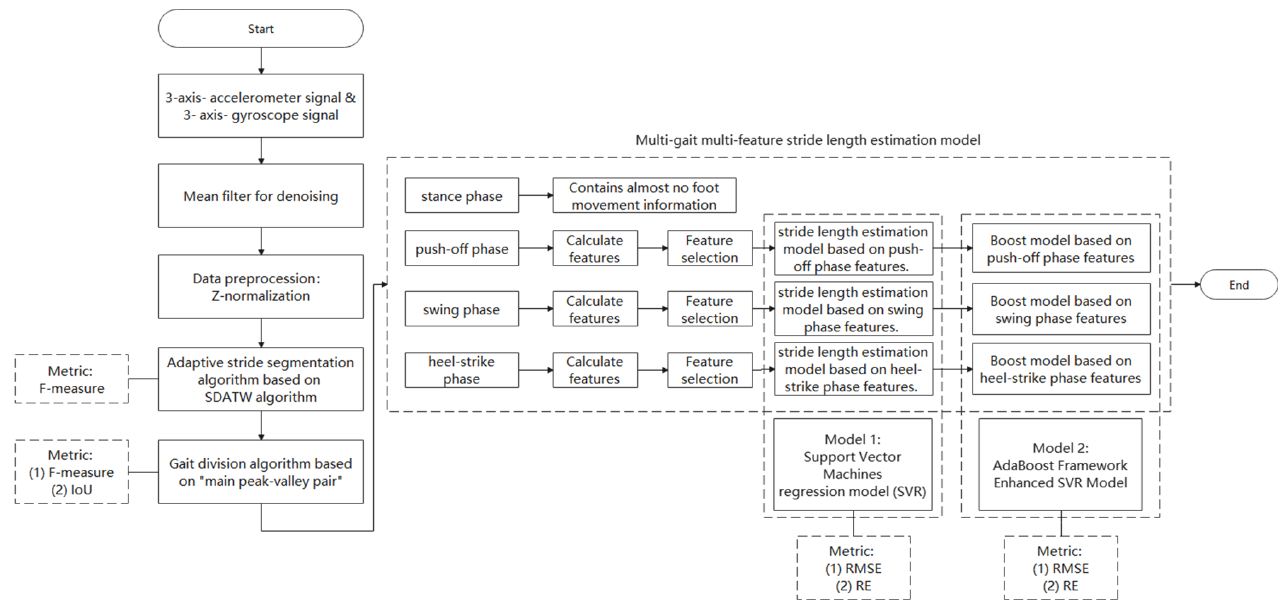
Figure 8. System frame diagram.